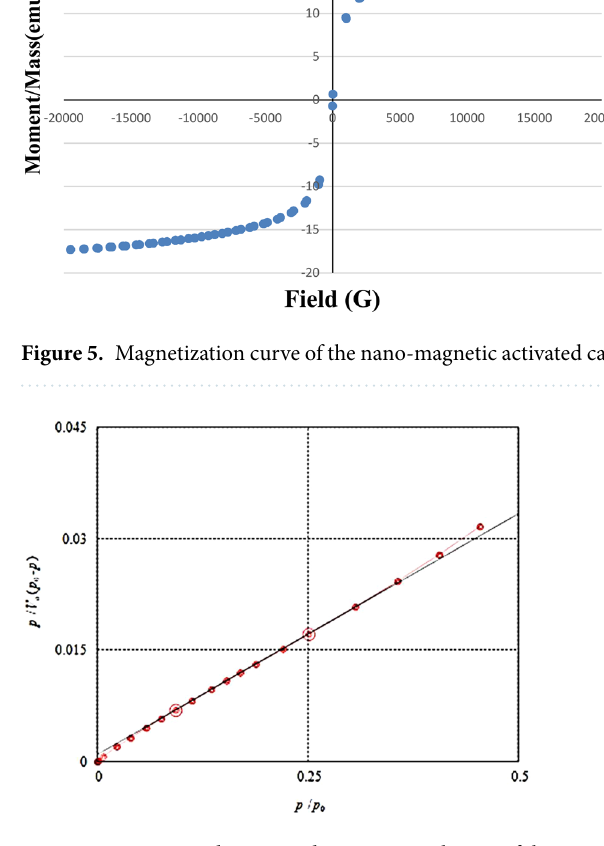
Figure 6. Nitrogen adsorption-desorption isotherms of the nano-magnetic activated carbon